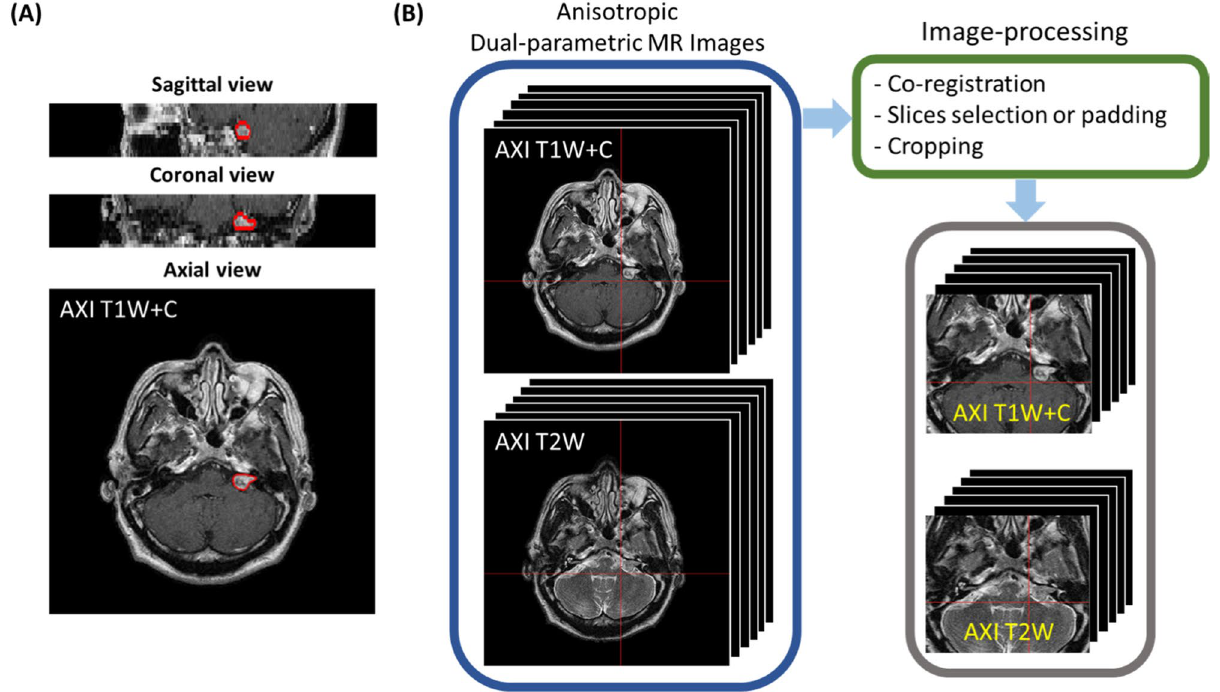
Figure 4. ( A ) Sagittal, coronal, and axial views of anisotropic MR images; ( B ) these raw MR images will be processed follow the steps showing here: co-registration between the various parametric images, and unified the image volume size before input our proposed dual-pathway U-Net model.